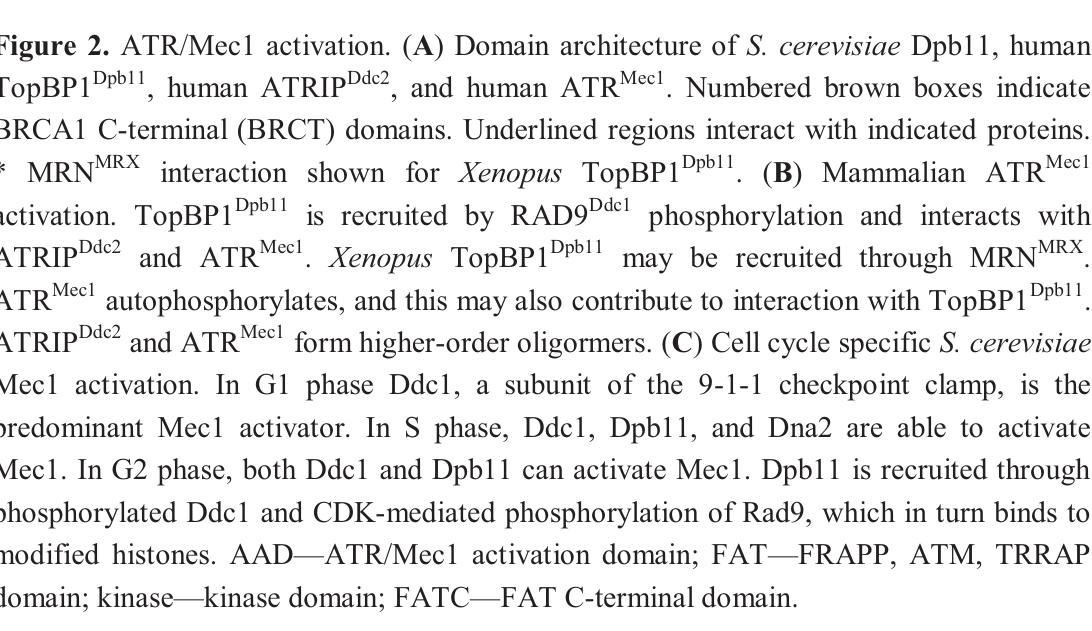
Figure 2. ATR/Mec1 activation. ( A ) Domain architecture of S. cerevisiae Dpb11, human TopBP1 Dpb11 , human ATRIP Ddc2 , and human ATR Mec1 . Numbered brown boxes indicate BRCA1 C-terminal (BRCT) domains. Underlined regions interact with indicated proteins. * MRN MRX interaction shown for Xenopus TopBP1 Dpb11 . ( B ) Mammalian ATR